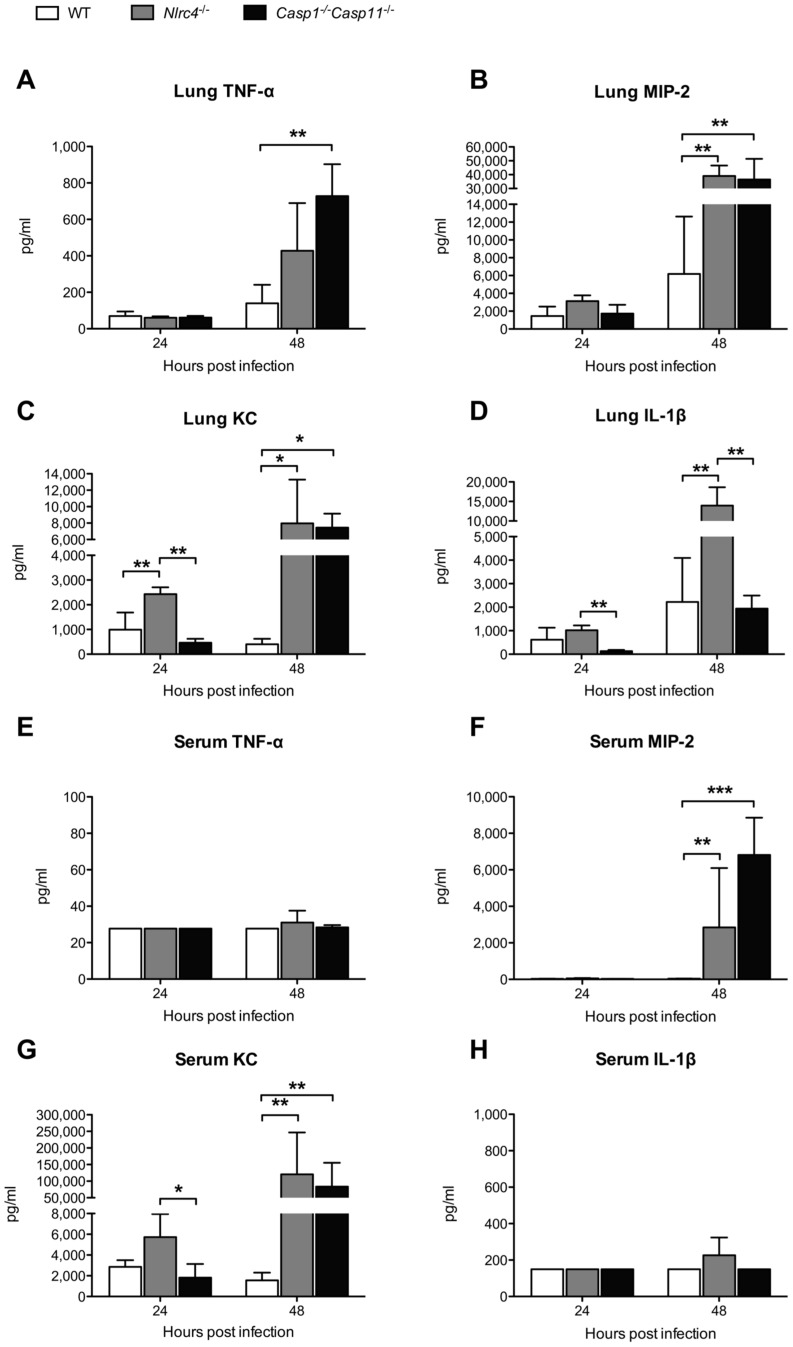
Differential Nlrc4- and Caspase/Caspase11-dependent lung and serum cytokine responses in respiratory melioidosis.Wild type (WT), Nlrc4
−/−, and Casp1
−/−
Casp11
−/− mice were infected with 314 CFU/lung aerosolized B. pseudomallei 1026b. TNF-α, MIP-2, KC, and IL-1β were measured in lung homogenate (A–D) and serum (E–H) 24 and 48 hours after infection. Data displayed are means ± SD and represent one of two comparable experiments. N = 4 per group per timepoint except N = 3 for Casp1
−/−
Casp11
−/− mice at 24 h. *, p≤0.05. **, p≤0.01, ***, p≤0.001.